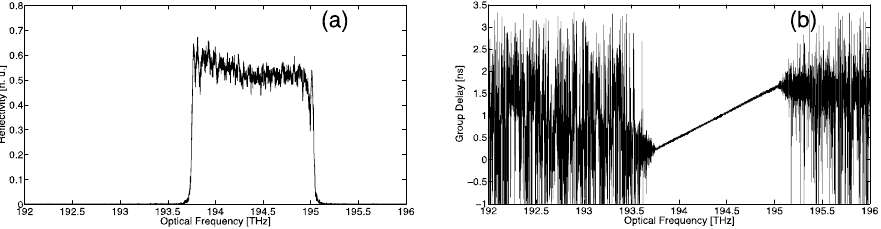
Figure 6. Measured reflection spectral characteristic of a typical linearly-chirped FBG: ( a ) Reflectivity versus optical frequency, and ( b ) reflection group delay with a linear slope of 1100 ps 2 .